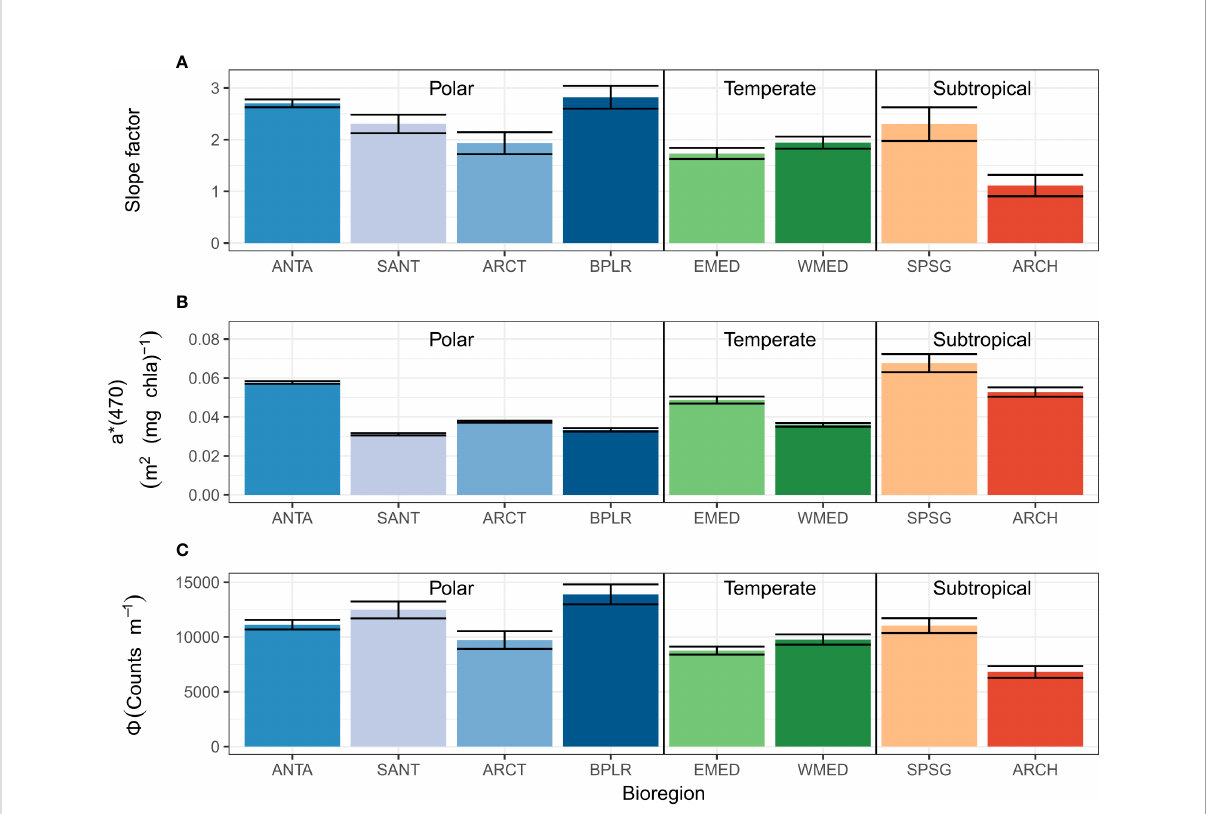
FIGURE 8 (A) Distribution of the slope factor, de fi ned as the coef fi cient of the regression between [Chla] Fluo and [Chla] HPLC , (B) Chla-speci fi c absorption coef fi cient at 470 nm, a*(470) (m 2 (mg Chla) -1 ), and (C) fl uorescence quantum yield, F (counts m -1 ), for the eight bioregions of the Glo-Argo dataset (ANTA, Antarctic Province; ARCH, Archipelagic Deep Basin Province; ARCT, Atlantic arctic Province; BPLR, Boreal Polar Province; EMED, Eastern Mediterranean Sea; SANT, Subantarctic Province; SPSG, South Paci fi c Subtropical Gyre Province; WMED, Western Mediterranean Sea). The error bars indicate 95% con fi dence